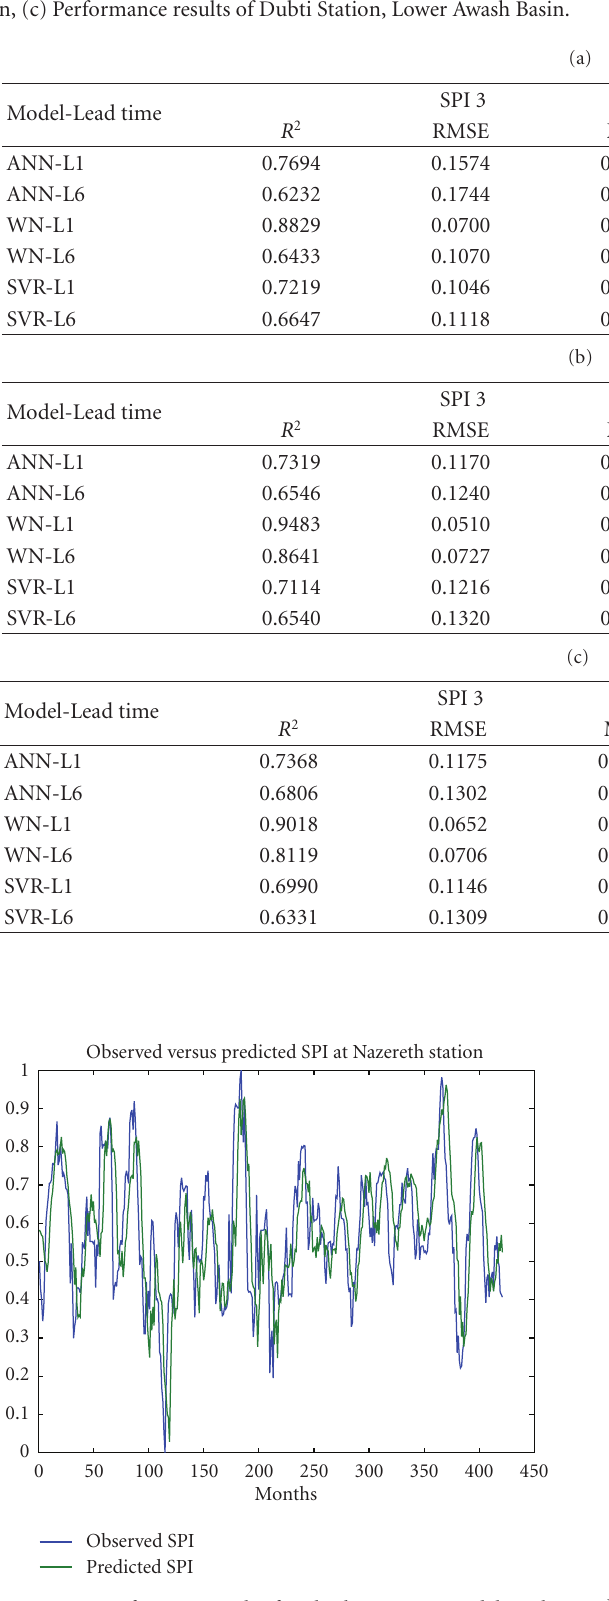
Figure 5: SPI 12 forecast results for the best ANN model at the Nazereth station (1 month lead time).